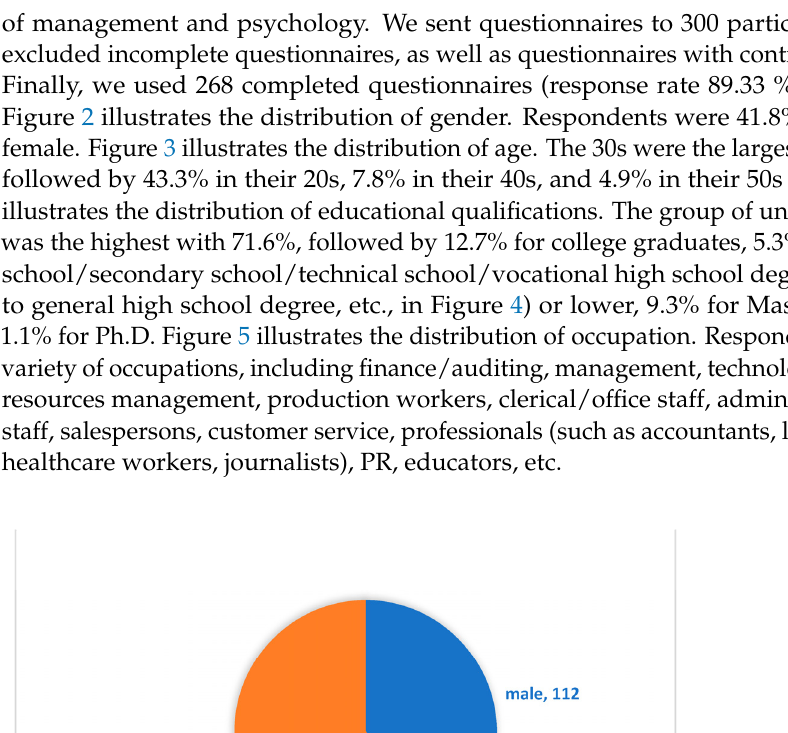
Figure 4. Distribution of educational qualifications (numbers in figure represent an actual number of test subjects in each group). Figure 5. Distribution of occupation (numbers in figure represent an actual number of test subjects in each group).